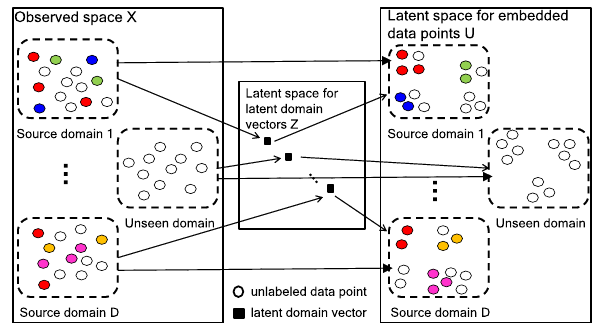
Fig. 1 Illustration of the proposed method. Same colors represent similar data points and different colors represent dissimilar data points, although data points with no color represent unlabeled data. Similar data points are close and dissimilar data points are sepa- rated in the latent embedding space. Each domain is represented by a latent domain vector, and data embeddings (latent feature vectors) are inferred by using the latent domain vectors. After training, our method can infer data embeddings for unseen domains given unla- beled data in the